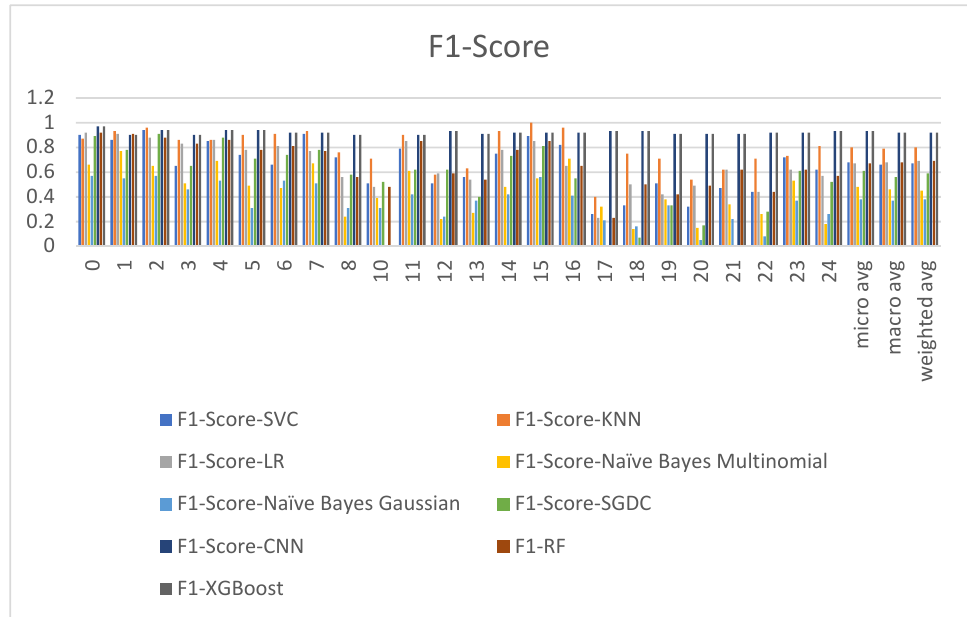
Figure 6. F1 Score. Figure 6. F1 Score.